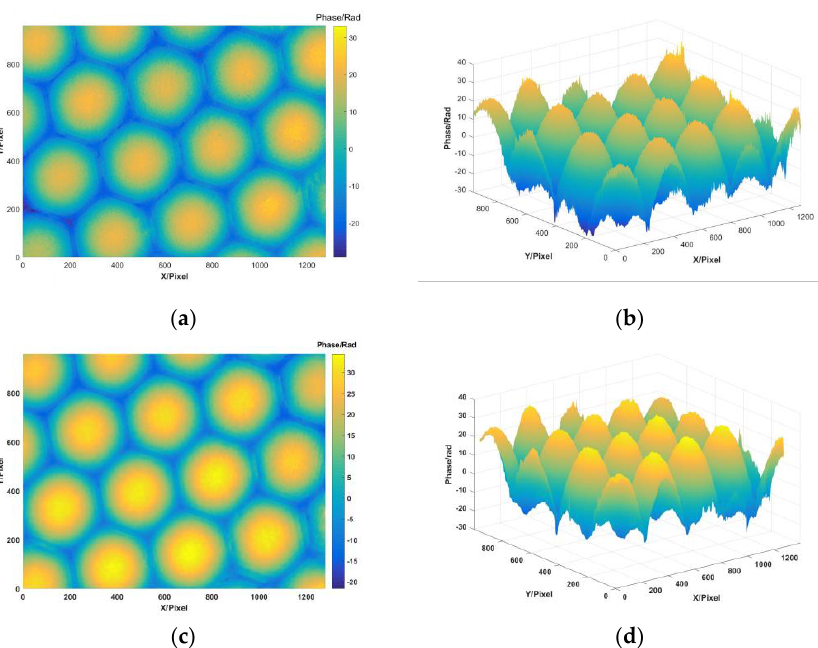
Figure 6. The results of phase measurements for the micro-lens array, including ( a ) the 2D map and ( b ) the 3D distribution reconstructed by phase shifting, ( c ) the 2D map, and ( d ) the 3D distribution reconstructed by fast Fourier transform.